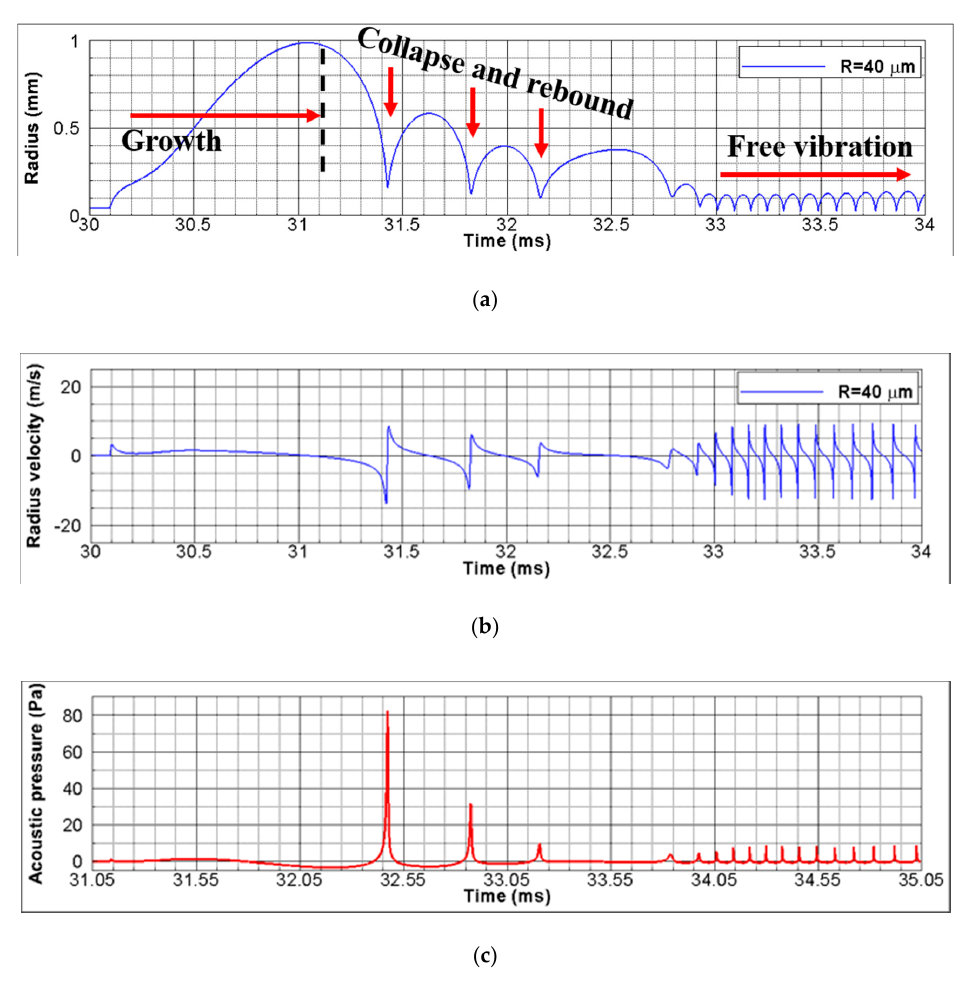
Figure 24. ( a ) Bubble radius; ( b ) radius velocity on the arbitrary single bubble; and ( c ) acoustic pressure at a narrow time interval.